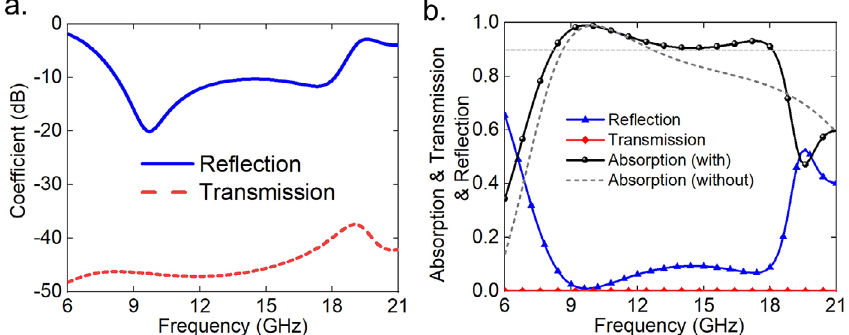
Fig. 2. (a) Simulated re fl ection and transmission coef fi cient of the proposed metamaterial absorber. (b) Simulated frequency- dependent absorption, transmission, and re fl ection of the metamaterial absorber. Dotted curve shows the absorption of the absorber without via